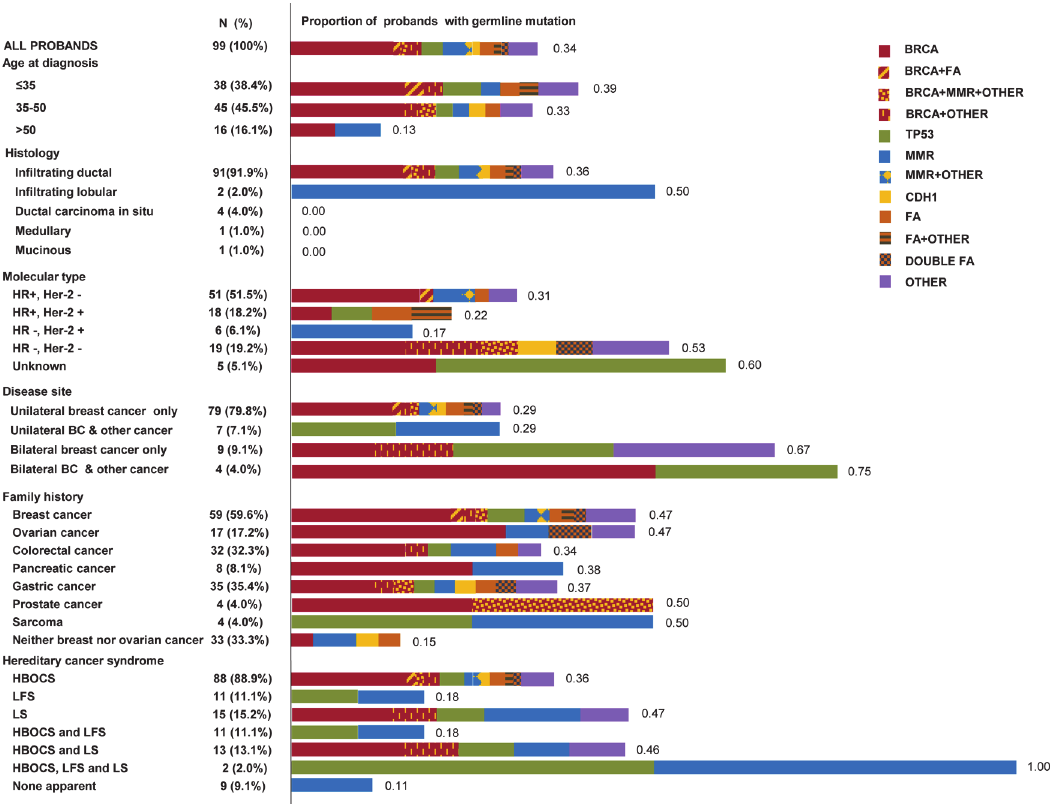
Fig 1. Characteristics of 99 probands and their families, and proportions of probands with germline deleterious mutations. This figure consisted of two aspects. The left column presented the overview of characteristics of the 99 probands and their families. It provided the numbers and proportions of each subgroup. The right color lumps reflected the proportions of probands with different gene mutations in each subgroup. The numbers on the right side of the color lumps represented the proportions. Proportions of probands with one gene mutation are shown in pure color squares, and proportions of probands with mutations in two or more genes are shown in two-color squares. Abbreviations and definitions are as follows: HR, hormone receptor; Her-2, human epidermal growth factor receptor 2; BC, breast cancer; HBOCS, hereditary breast and ovarian cancer syndrome; LFS, Li-Fraumeni syndrome; LS, Lynch